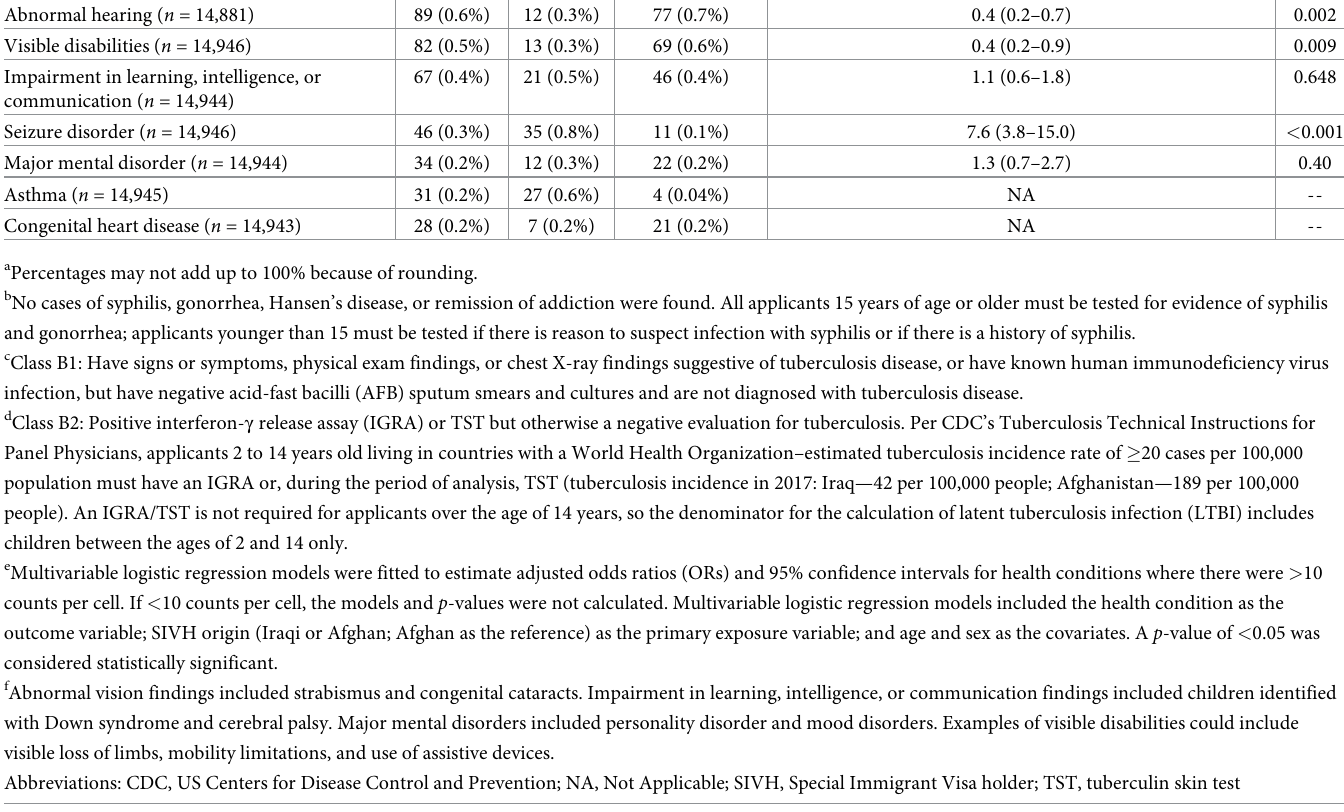
Sixteen children had abnormal tuberculosis test findings: 3 (0.02%) had an abnormal chest X-ray with negative sputum cultures (Class B1) and, among those who received a tuberculin skin test (TST), 13 (0.1%) had a positive TST but negative chest X-ray (Class B2) (Table 2). Vision abnormalities were noted in 566 (4%) children, with Iraqis twice as likely to have vision abnormalities (OR: 1.9, 95% CI 1.6–2.2, p < 0.001). Among children reported with vision abnormalities, strabismus was reported for 92 children (0.5%). Hearing abnormalities were noted in 89 (0.6%) children, with Iraqis less likely to have hearing abnormalities (OR: 0.4, 95% CI 0.2–0.7, p = 0.002). Seizure disorders were noted in 46 (0.3%) children, with Iraqis more likely to have a seizure disorder (OR: 7.6, 95% CI 3.8–15.0, p < 0.001). No cases of syphilis, gonorrhea, or Hansen’s disease were found.